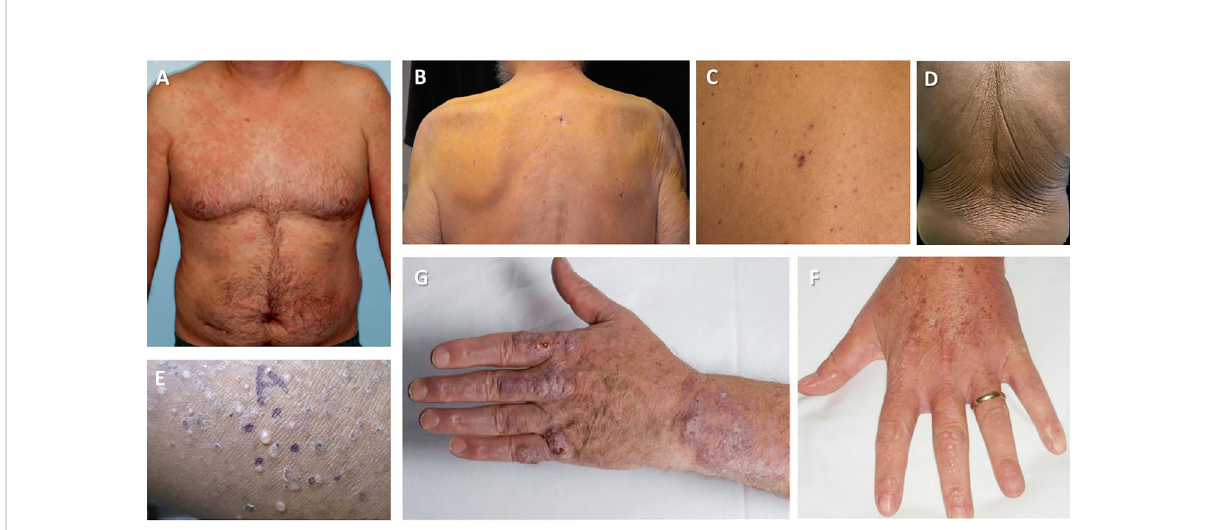
FIGURE 2 Cutaneous manifestations of MGCS. (A) Schnitzler syndrome (Image courtesy: Wilmas et al. 2018 (55)) (B) Nonhyperlipidemic xanthomatosis (Image courtesy: Cohen et al. 2015 (56)) (C) Telangiectasias in TEMPI syndrome (Image courtesy Khan et al., 2014 (57)) (D) Acquired cutis laxa (Image courtesy: Shalhout et al., 2010 (58)) (E) Subcorneal pustular dermatosis (Image courtesy: Young et al., 2021 (59)) (G) Necrobiotic xanthogranuloma (Image courtesy: Inthasotti et al. 2010 (60)) (F) Scleromyxedema (Image courtesy: Claveau et al. 2022